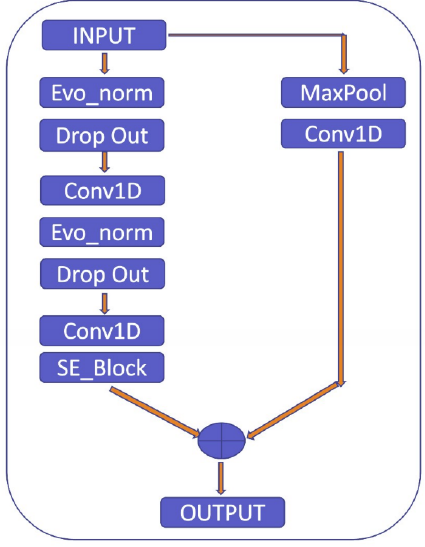
Figure 10. Residual block.